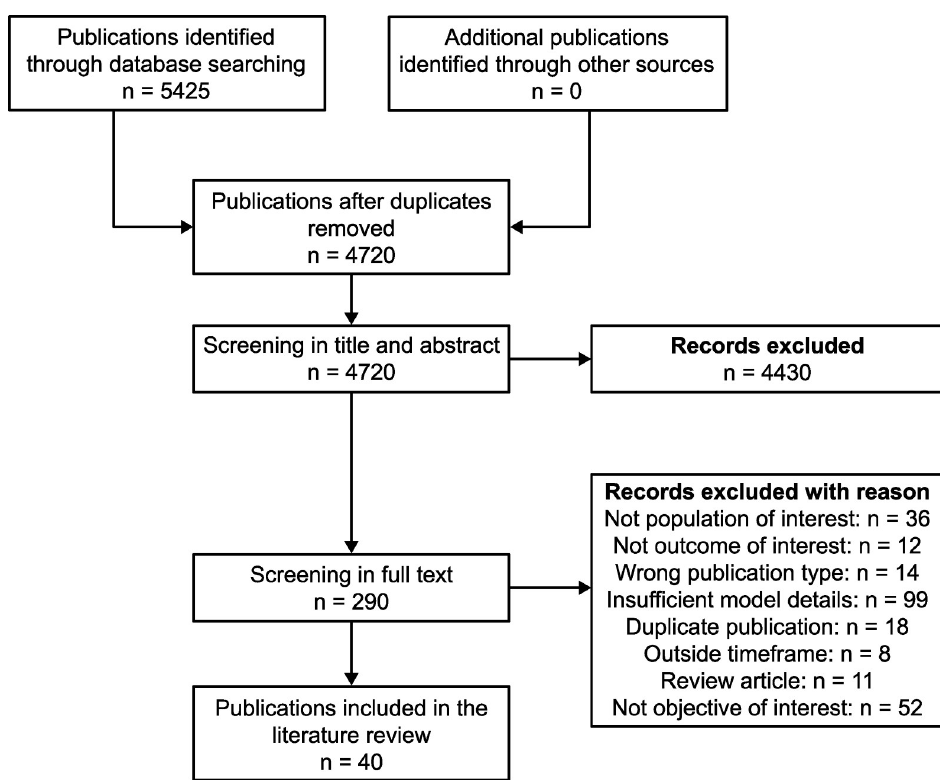
Fig 1. PRISMA flow diagram. PRISMA, Preferred Reporting Items for Systematic Reviews and Meta-Analyses.